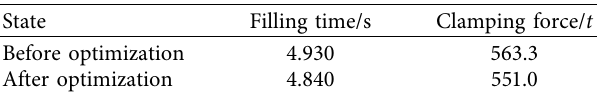
Figure 14: Optimized clamping force diagram. Table 2: Comparison of data before and after gate position